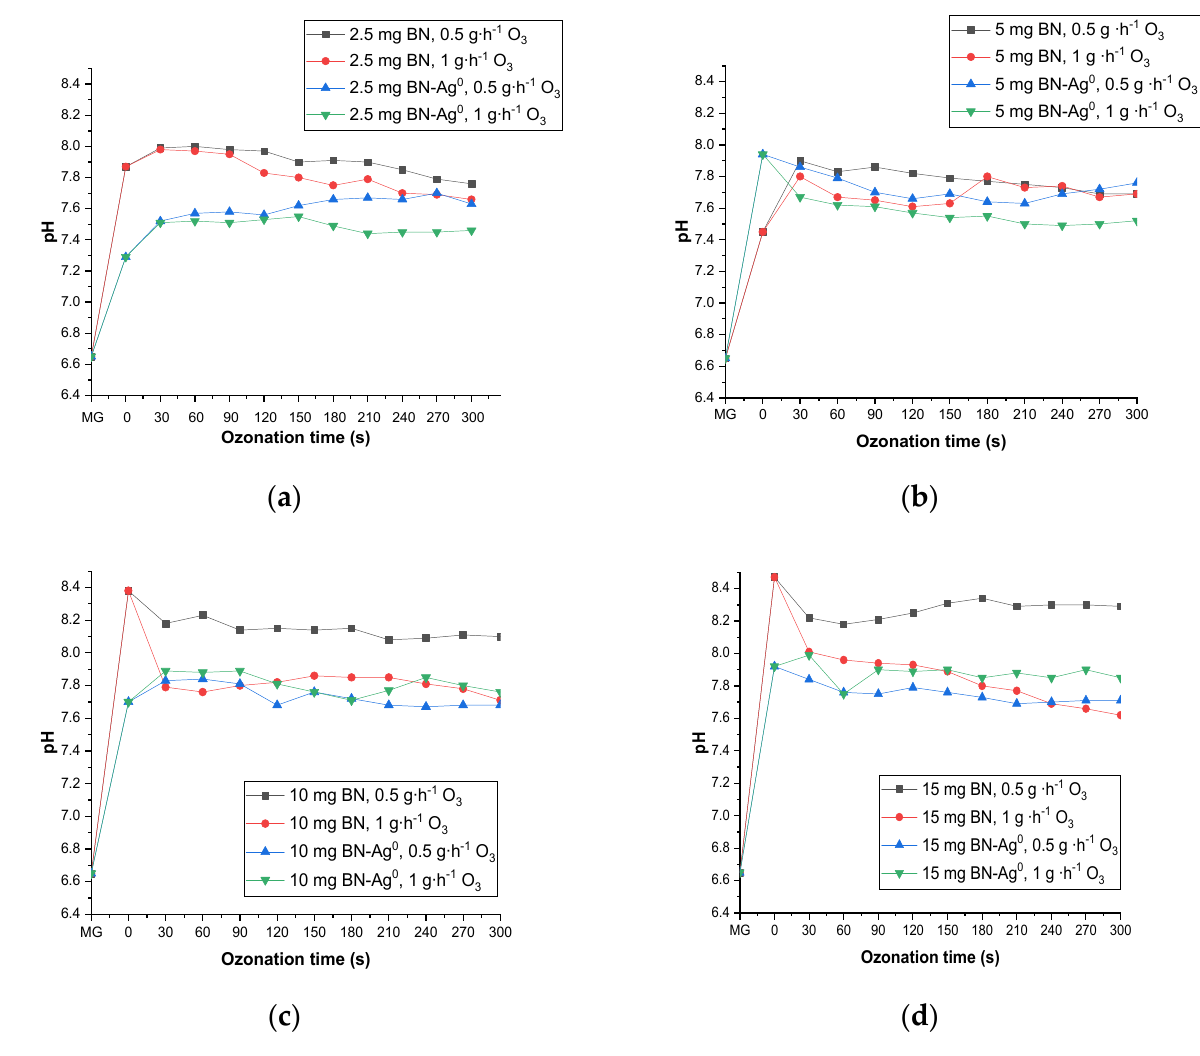
Figure 13. The influence of ozonation time on the pH of the MG solution (20 mL, initial pH = 6.65) ozonated with different amounts of BN and BN-Ag 0 : 2.5 mg ( a ), 5 mg ( b ), 10 mg ( c ), 15 mg ( d ); 0.5 and 1 g ∙ h − 1 O 3 ; ozonation time (0–300 s).